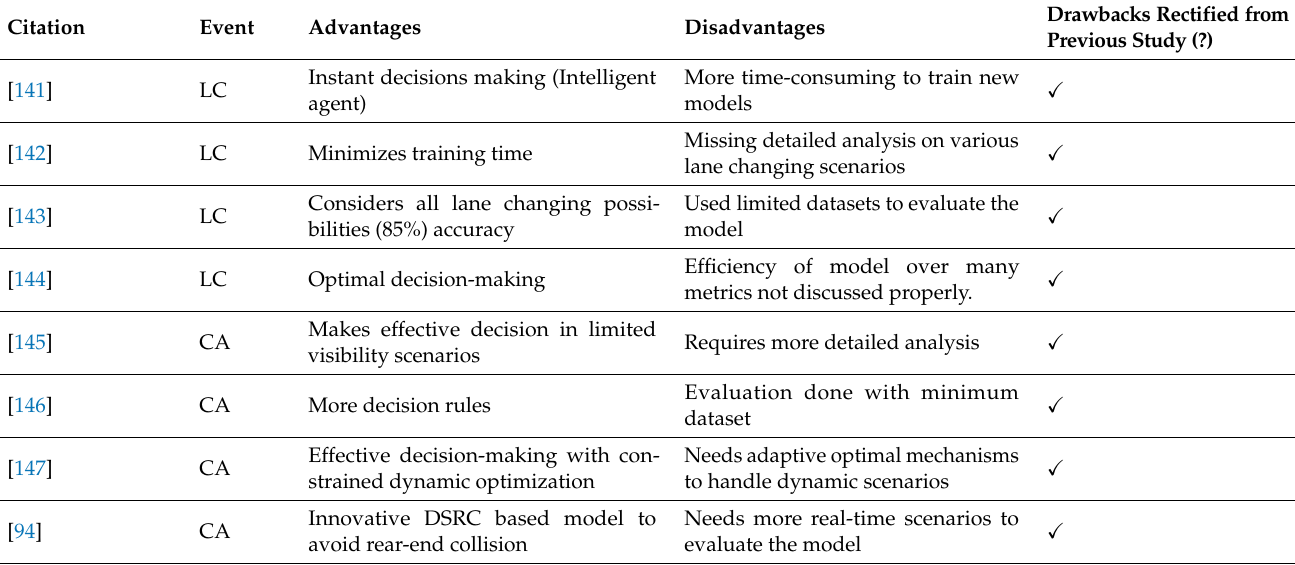
Table 7. Chronological summary of the decision-making for Lane Change (LC) and Collision Avoidance